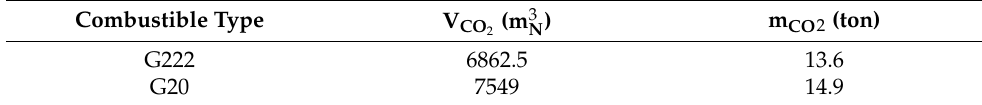
Table 5. Theoretical values for carbon dioxide emissions.